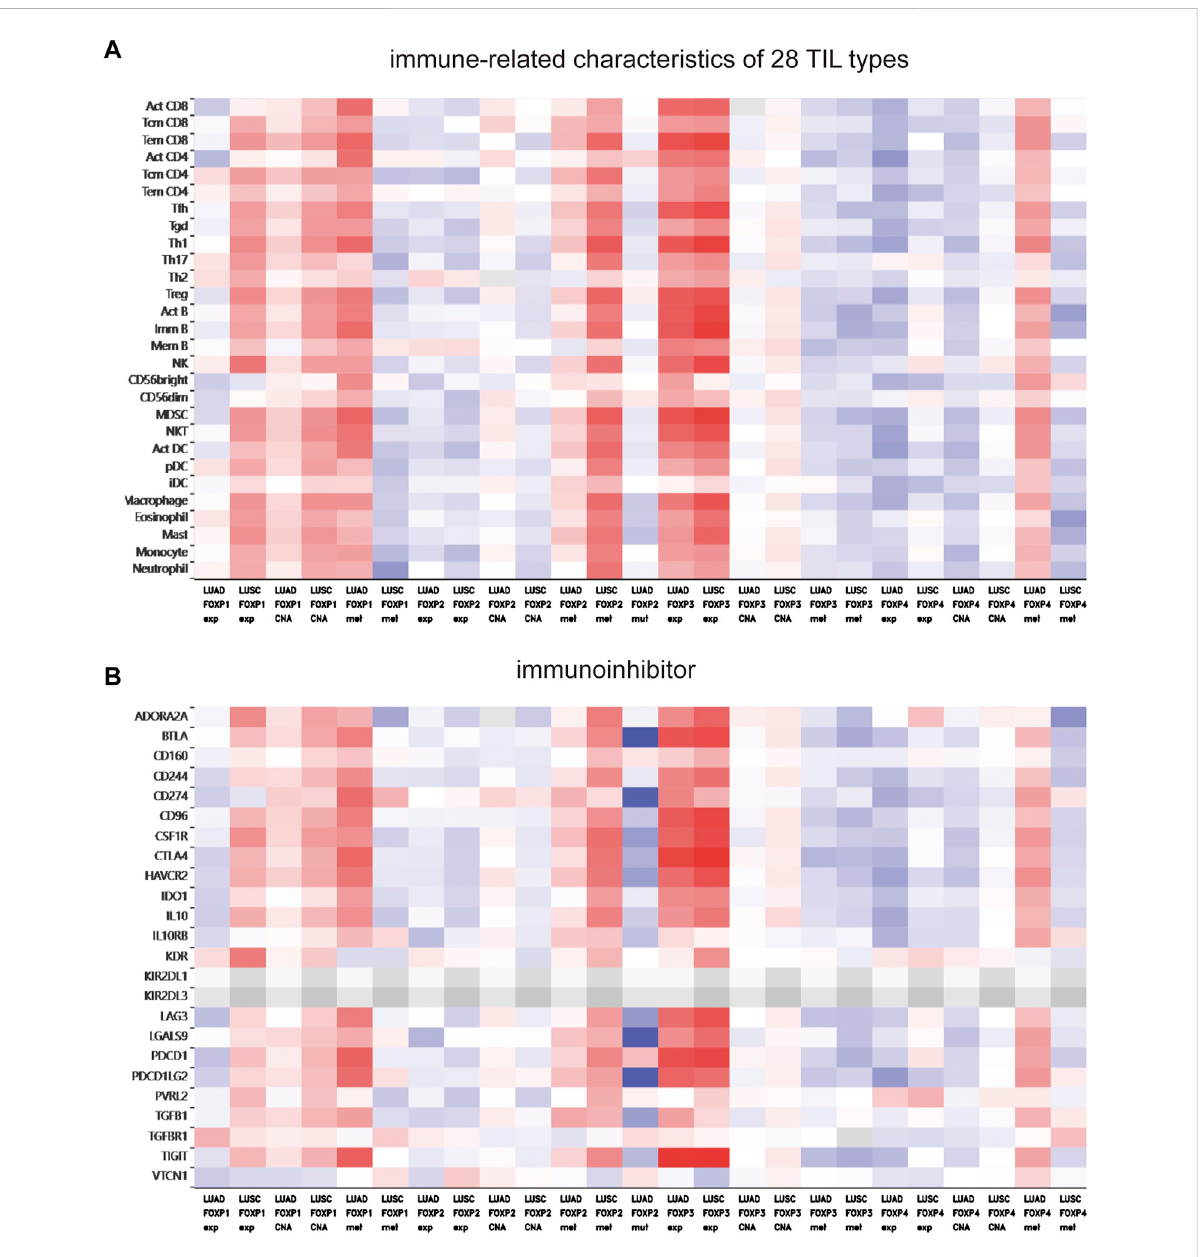
FIGURE 9 The relationshipbetweenthe degree of immunefactors in fi ltration in NSCLC and the expression ofFOXPfamily. (A) The hotmap presented the correlations between the FOXP family and immune-related characteristics of 28 TIL types. (B) The hotmap presents the correlations between the FOXP family and